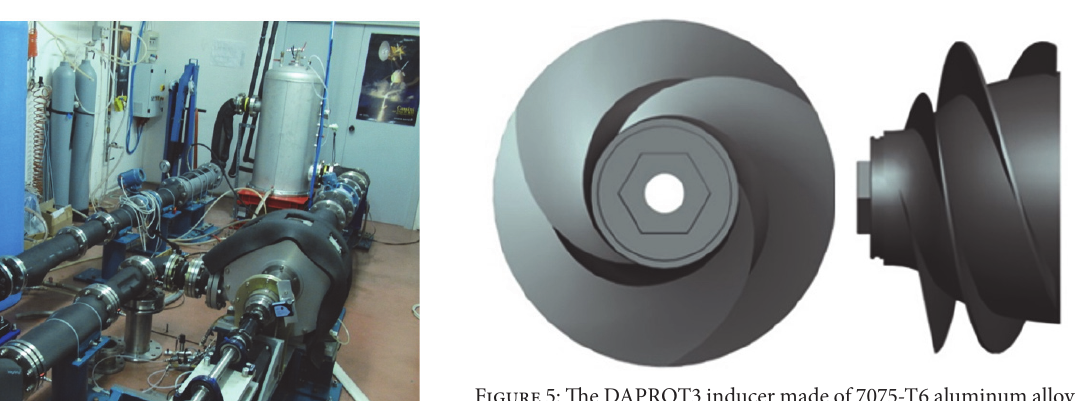
Figure 5: The DAPROT3 inducer made of 7075-T6 aluminum alloy with Sanford surface treatment.